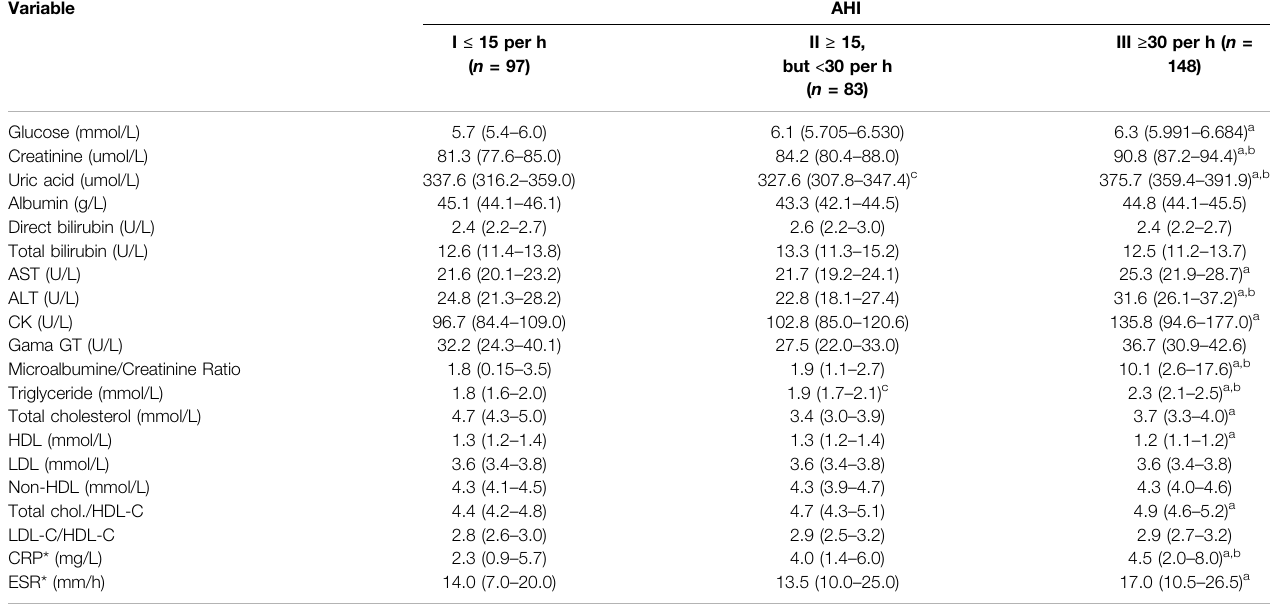
TABLE 2 | Clinical, lipids and in fl ammation parameters of the study population according to OSA